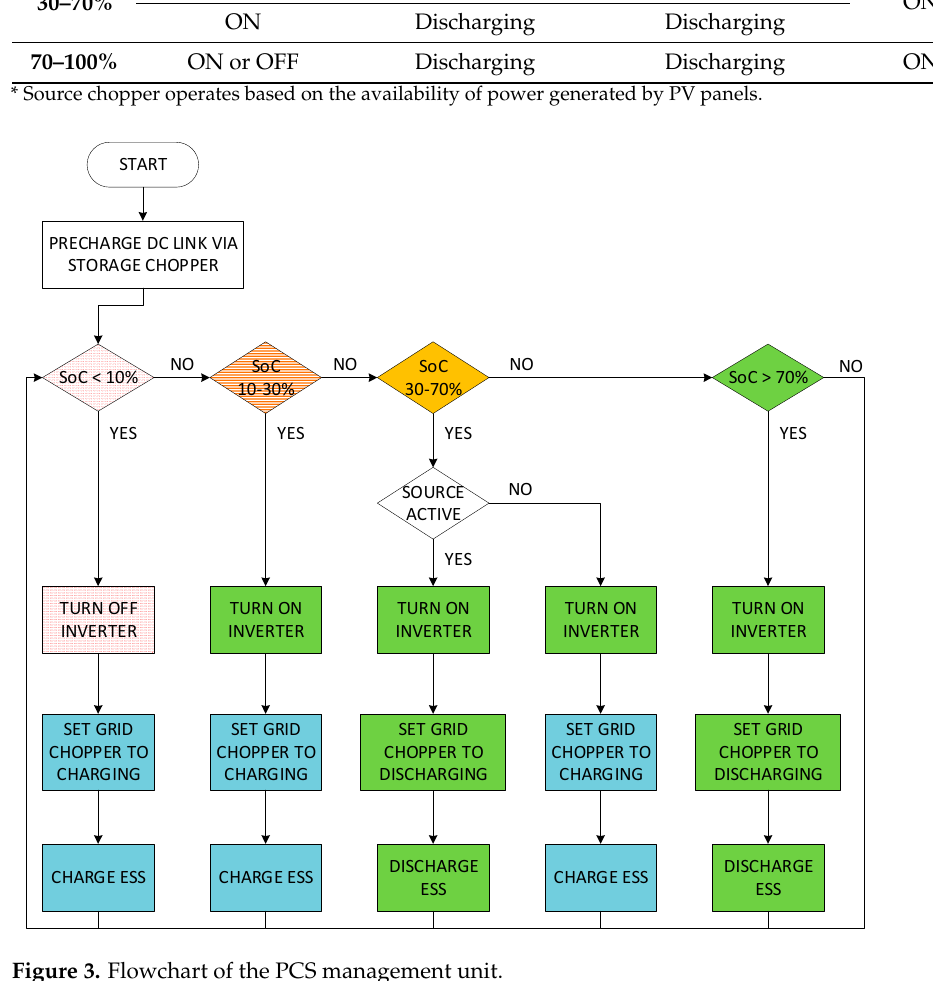
Figure 3. Flowchart of the PCS management unit. The proposed DC microgrid system has the capability of working both as a single- point and multi-point system to serve single or multiple clusters of loads. Figure 4 shows the multi-point configuration with different kinds of loads. A single-point system converts